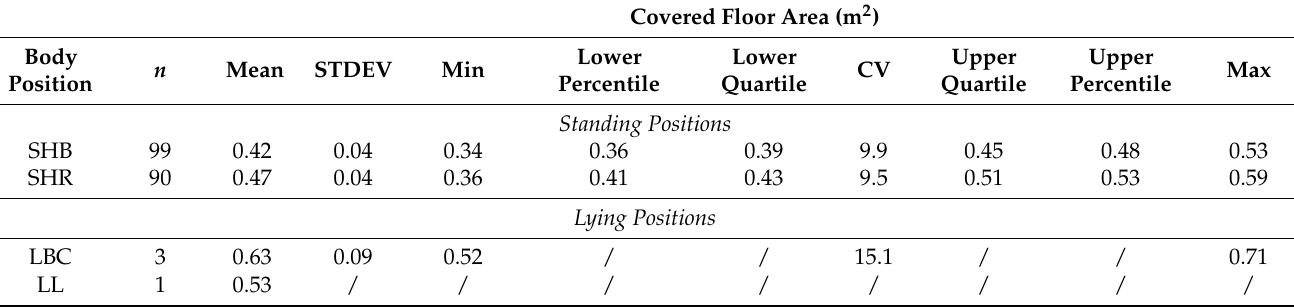
Table 5. Measured floor area covered by an individual sow’s body in different body positions (with SHB = Standing head bowed, SHR = Standing head half or fully raised, LBC = Lying in belly chest position, LL = Lying in the lateral position, STDEV = Standard Deviation, CV = coefficient of variation, Min = minimal value, Max = maximal value).